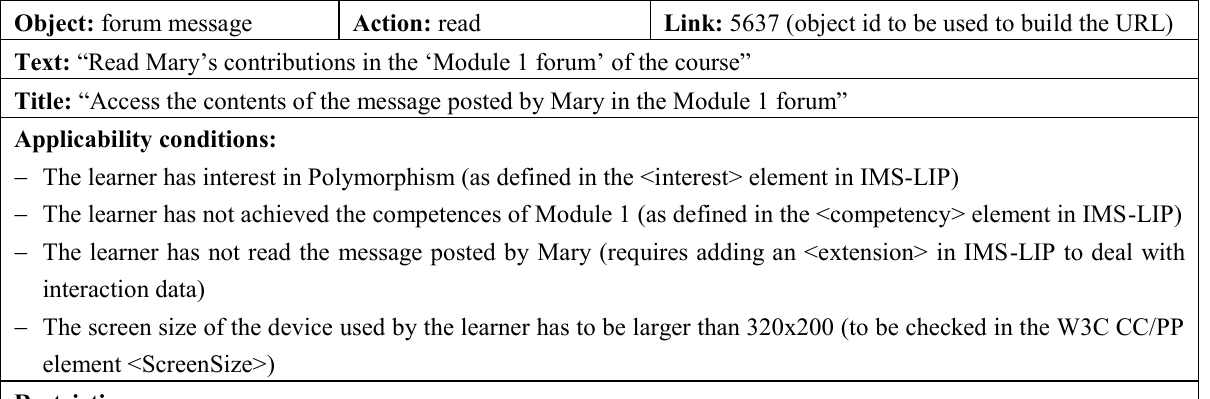
Table 5. Example of a recommendation described in terms of the recommendation